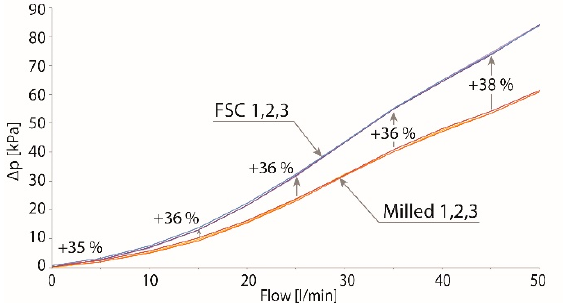
Figure 12. ( a ) Cooling Power (CP) of case study samples compared in similar thermal conditions. ( b ) Cooling power for FSC and milled samples with similar temperature di ff erence of calorimeter water and coolant flow. Adapted from [35].